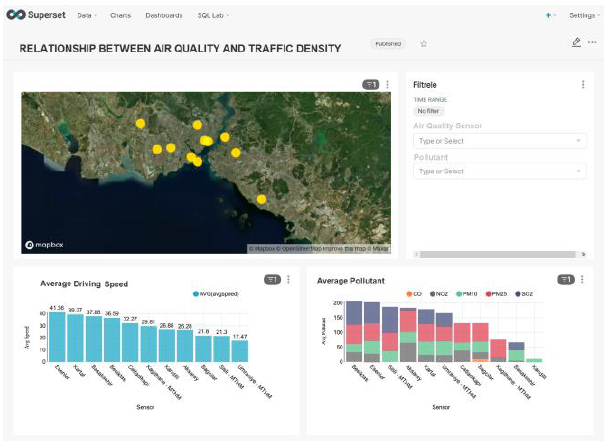
Figure 8. Designed GIS-based Dashboard Example for Istanbul